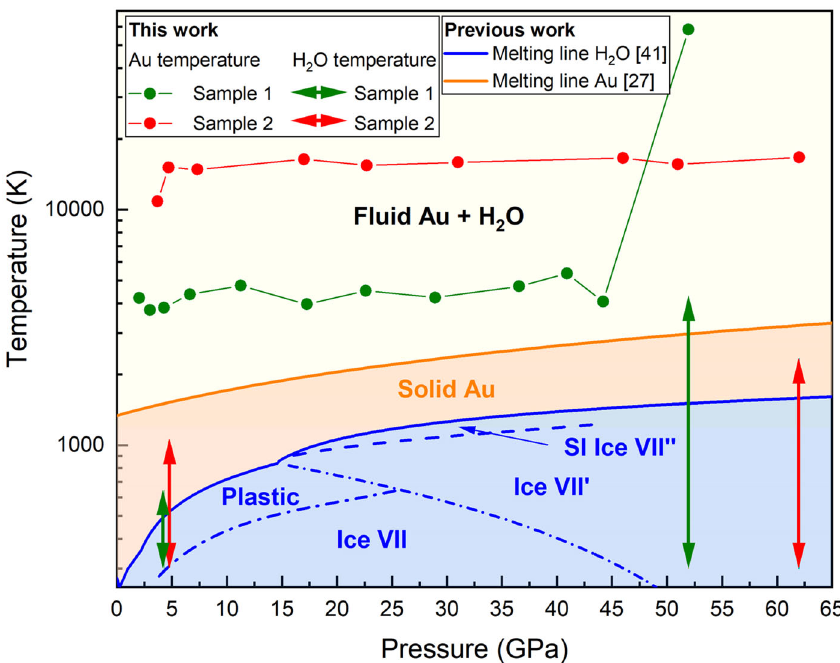
Fig. 6 Phase diagram of H 2 O and Au, showing the calculated temperatures determined in samples #1 (green) and #2 (red). The solid circles indicate the peak temperature reached at the center of the Au foil. The arrows show the range of temperatures in H 2 O at the time of maximum melting extent following heat conduction for selected pressures (Supplementary Fig. S10), as determined from FEA simulations. The melting lines of Au and H 2 O correspond to a Simon-Glatzel fi t to the data from Refs. 41 and 27 , respectively; phase lines in H 2 O are indicated by broken lines 41,42 , where SI indicates the superionic phase.